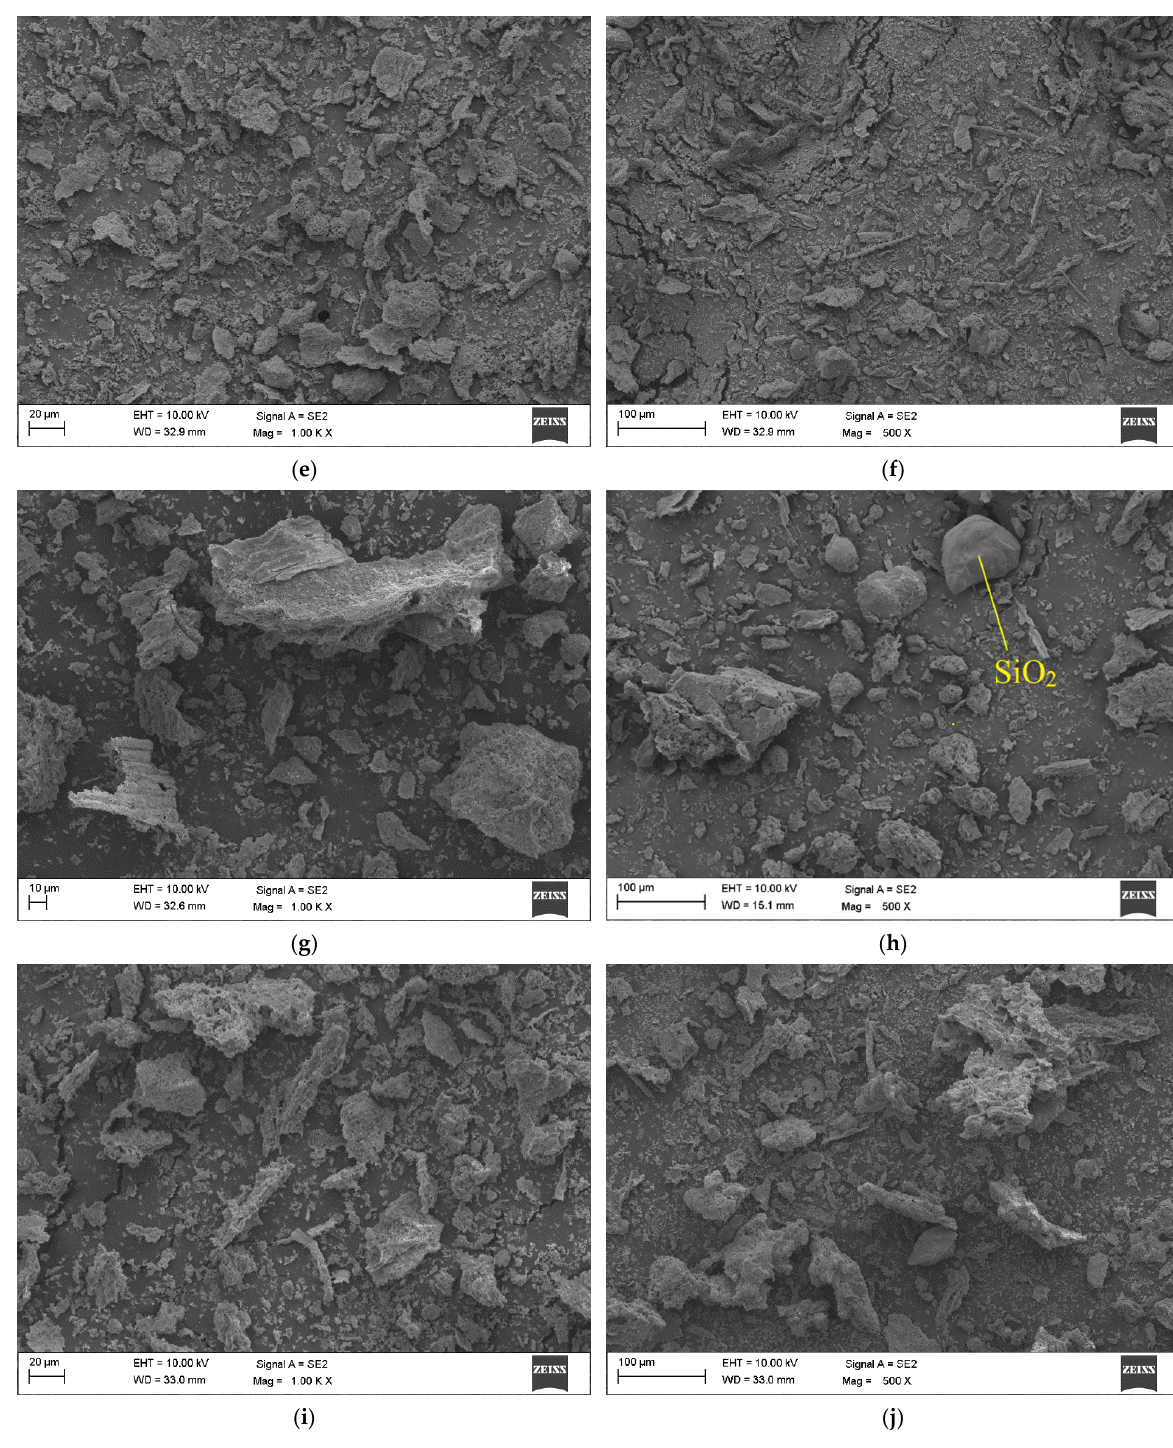
Figure 1. SEM pictures of ash samples. ( a ) CD1_FR; ( b ) CD1_FR; ( c ) CD2_FR; ( d ) CD2_FR; ( e ) CD3_IF; ( f ) CD3_IF; ( g ) CL1_FR; ( h ) CL1_FR; ( i ) CL2_IF; ( j ) CL2_IF.